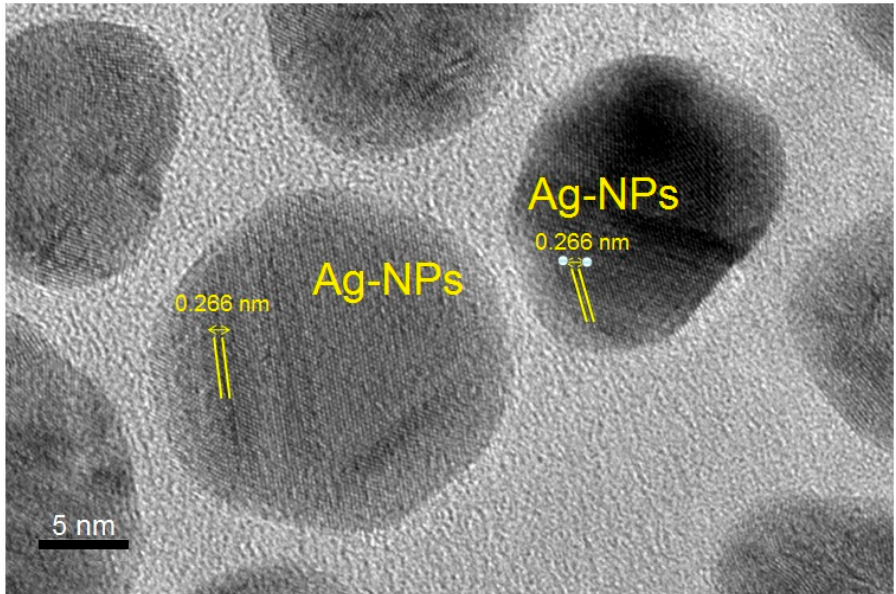
Figure 9. Lattice analysis of C-Ag NPs from C2 (0.25 g) samples. A thin layer of curcumin can be noticed around nanoparticles.